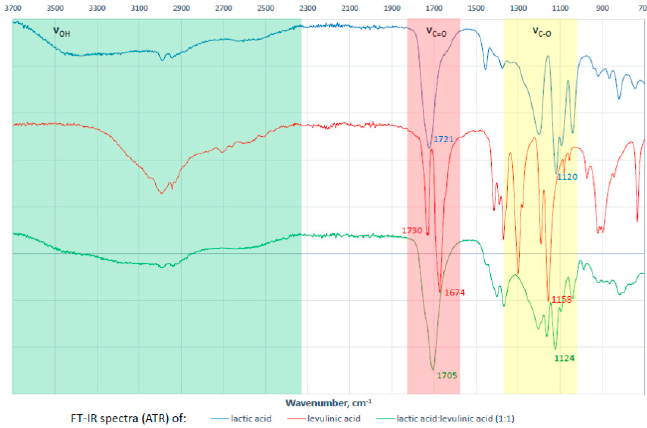
Figure 6. Changes in FT-IR spectra during NADES 17 formation (lactic acid:levulinic acid;